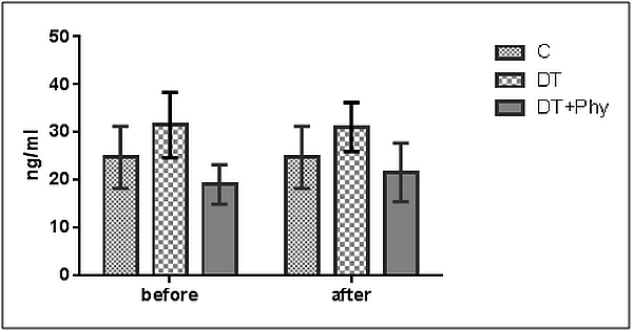
Figure 2. Mean values before and after treatments / dog groups (C = Control, DT = Drug therapy, DT + Phy = Drug therapy + Physiotherapy) revealing no significant statistical correlation between pain / dog